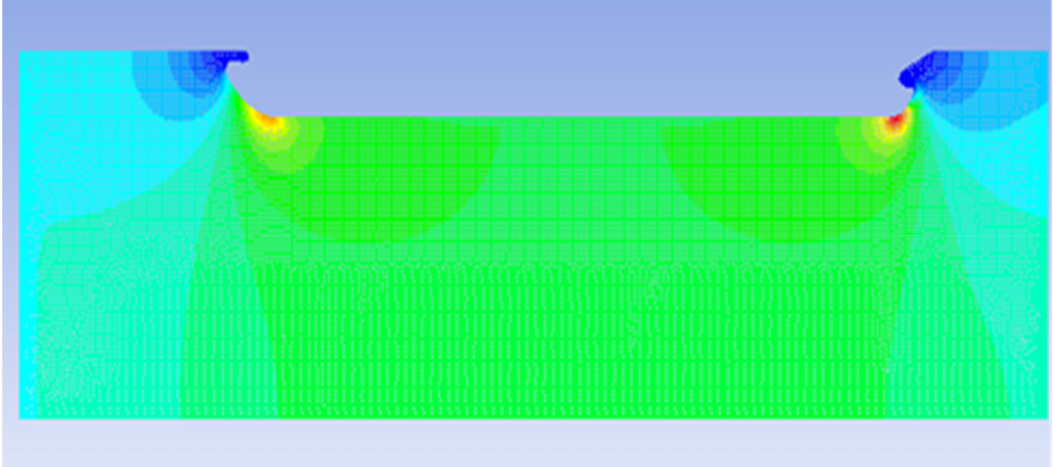
Figure 3. Distribution of dynamic pressure in the flow-field.